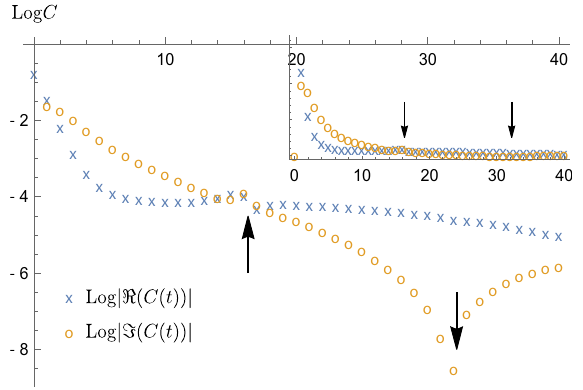
Fig. 2 The calculated time-domain two-photon autocorrelation func- tion. The light echoes (indicated by black arrows) are observed at inte- ger multiples of the light ring orbital period. The inset shows the same results without using the logarithmic scale